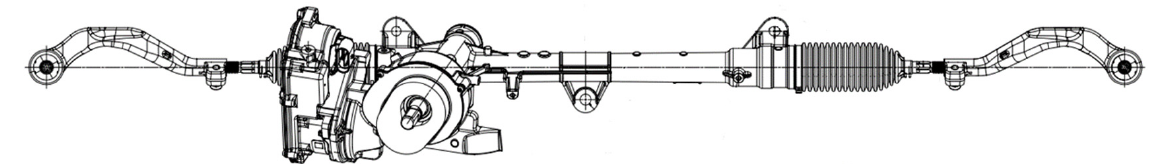
Figure 2. Investigated Electric Power Steering.